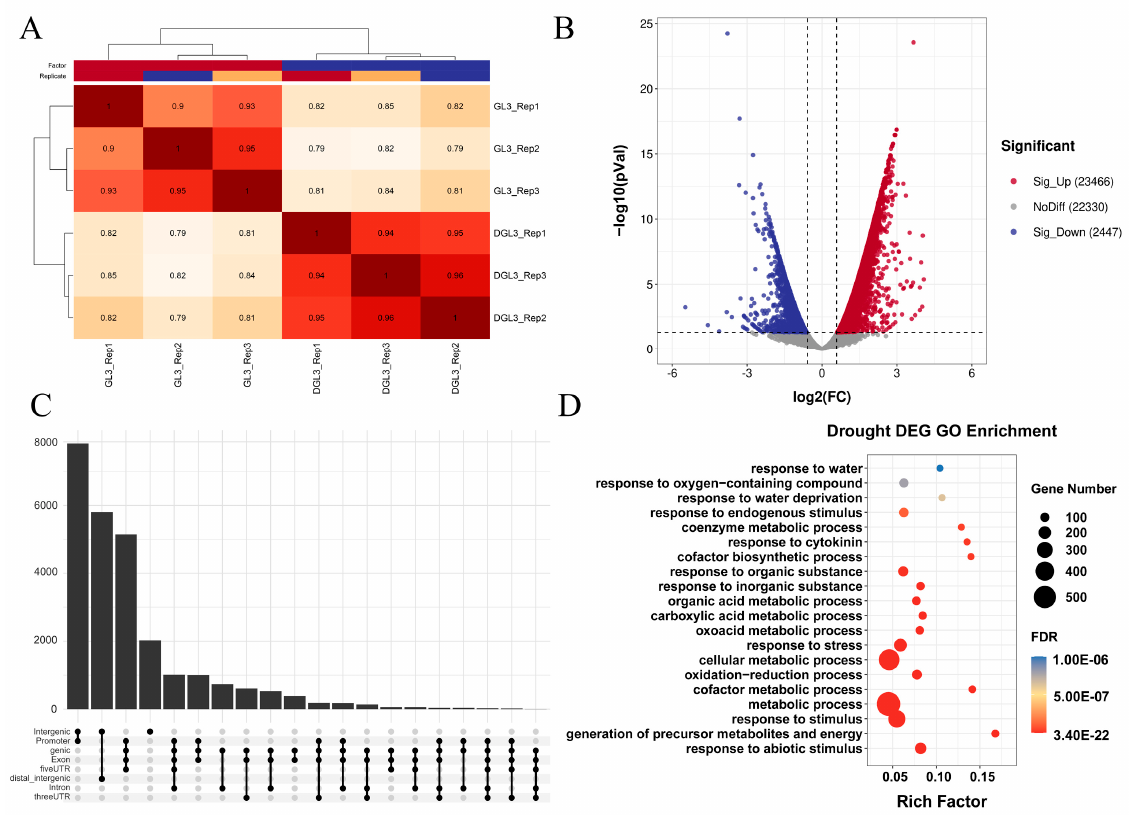
Figure 4. Results of differential ATAC analysis. ( A ) Correlation heatmap of six ATAC samples. Darker red means higher correlation. ( B ) Up- and down-regulation of differential ATAC signal. Genes marked in red are significantly up-regulated genes and those marked in blue are significantly down-regulated genes. ( C ) The distribution of differential ATAC signal intensity at different locations. ( D ) The GO enrichment of differentially expressed genes. Darker red means higher significance.